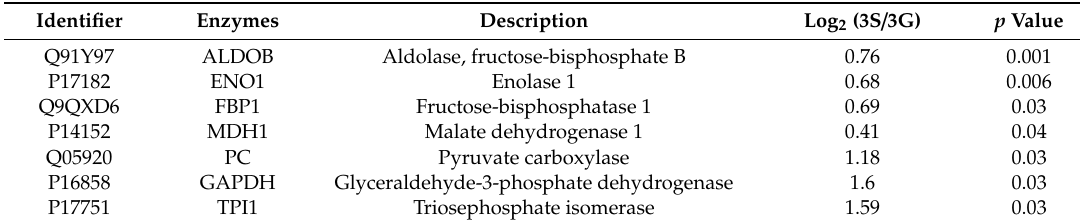
Figure 4. Comparison of canonical pathways between the 3S and 3G groups. Only two different pathways were shown to be related to glucose metabolism. The vertical line indicates a threshold of p < 0.05. Significant canonical pathways were determined by an ingenuity system pathway analysis. The x-axis displays the negative log of the p value calculated by Fisher’s exact test. The gluconeogenesis pathway is shown in a deeper blue color, indicating greater significance than the glycolysis. p values of gluconeogenesis and glycolysis were 1.5 × 10 − 8 and 6.12 × 10 − 7 , respectively. Table 5. Canonical pathway analysis of hepatic enzyme expressions in the gluconeogenesis pathway between two groups.